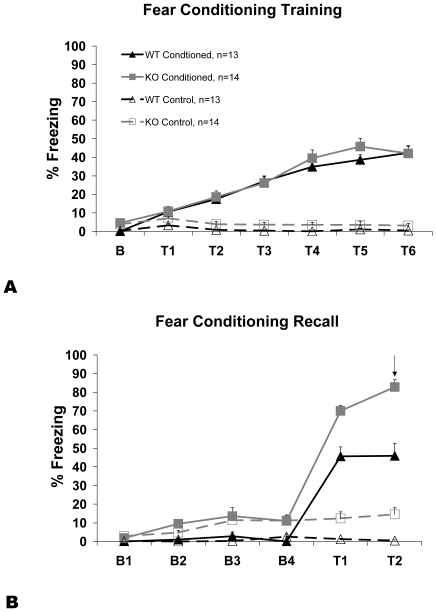
Fear Conditioning.5-HTT KO mice exhibit increased freezing specific to recall in a fear conditioning paradigm A) Training: WT and KO animals show similar freezing levels during training of fear conditioning. Time on the x-axis is labeled as ‘B’ for the entire two-minute baseline and each ‘T’ represents the thirty second tone and the following one-minute quiet period. The y-axis represents percent time freezing during the specific time point. B) Recall: KO mice compared to WT mice show significantly increased freezing during baseline and recall of a tone previously associated with foot shock. Time on the x-axis is represented in 30-second bins with ‘B’ for baseline and ‘T’ for tone exposure. The y-axis represents percent time freezing during the specific time bin. The arrow indicates time of radiotracer injection for the imaging data. Error bars represent standard error of the mean (shown only unilaterally for graphical clarity).